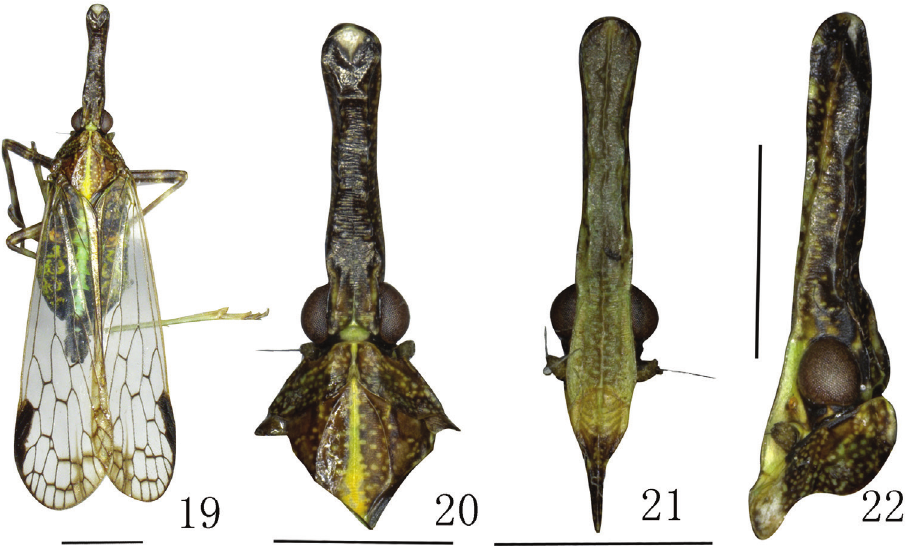
Figures 19–22. Saigona maculata Zheng & Chen sp. nov. 19 male, holotype, dorsal view 20 male, head and thorax, dorsal view 21 male, frons and clypeus, ventral view 22 male, head and pronotum, lateral view. Scale bars: 2 mm ( 19–22